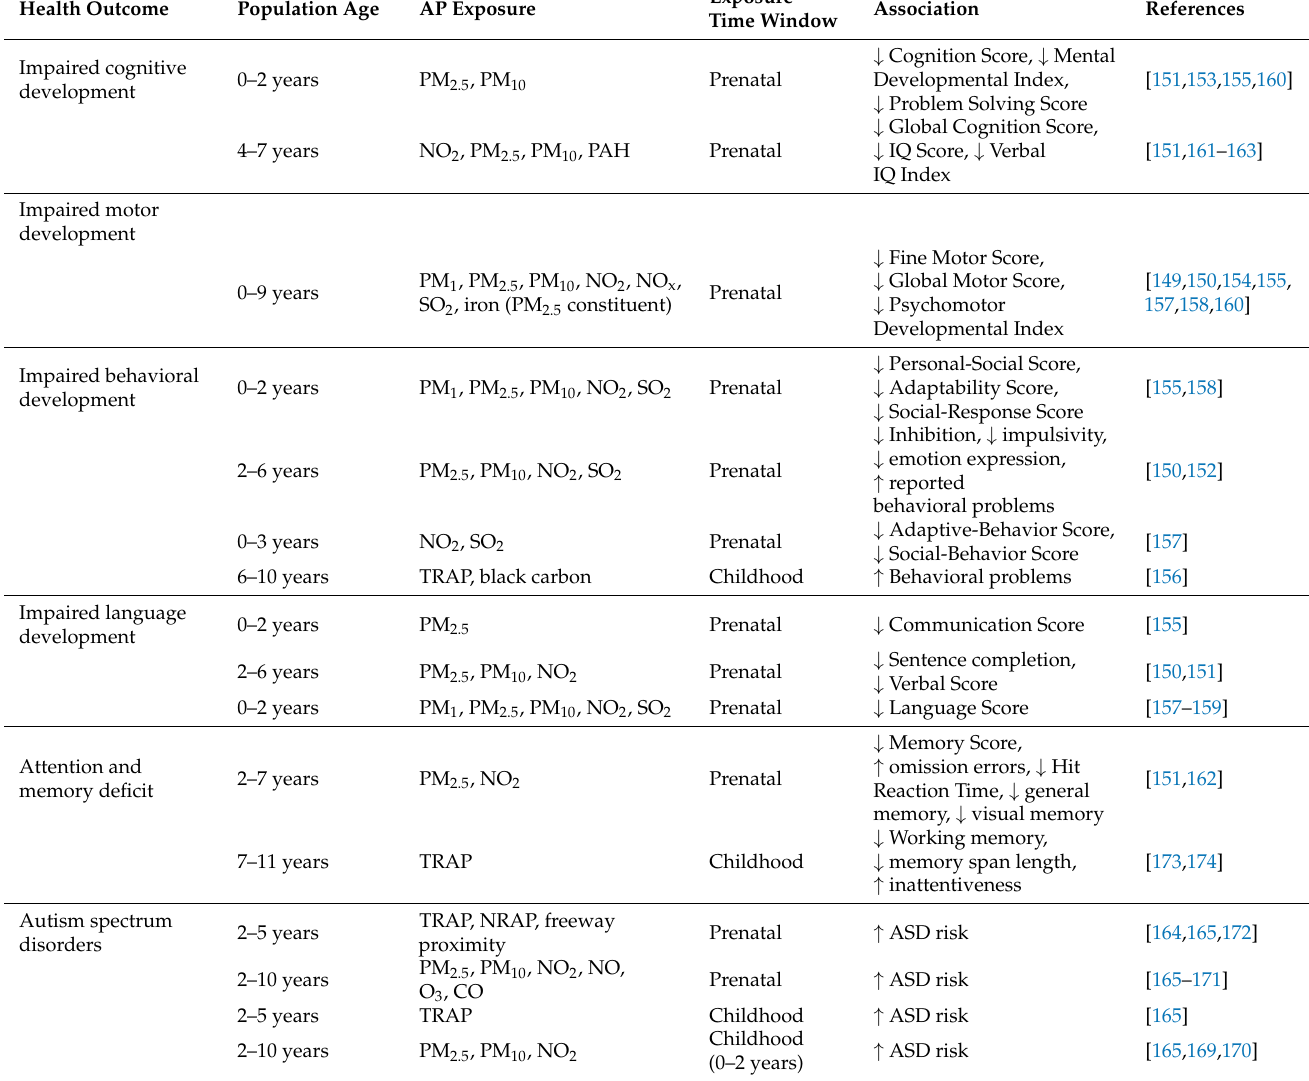
Table 3. Neuropsychological Outcomes Associated with Early-Life Air Pollution